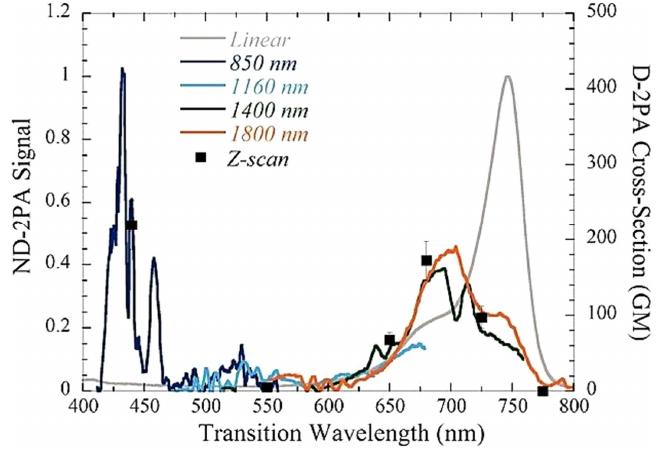
Figure 12. Nondegenerate 2PA spectra for a solution of selenopyrylium-terminated polymethine dye Se-3C dissolved in chloroform. Different pump wavelengths were used to observe the full ND-2PA spectra. Solid circles are degenerate 2PA (D-2PA) cross sections derived from femtosecond-pulsed Z -scan measurements. 1 GM is defined as 1 × 10 –50 cm 4 s photon –1 . Experimental uncertainties in the values were estimated to be ±10%. The linear absorption spectra are shown as reference. Reproduced from Hales et al. [87] with permission from the American Association for the Advancement of Science (AAAS).